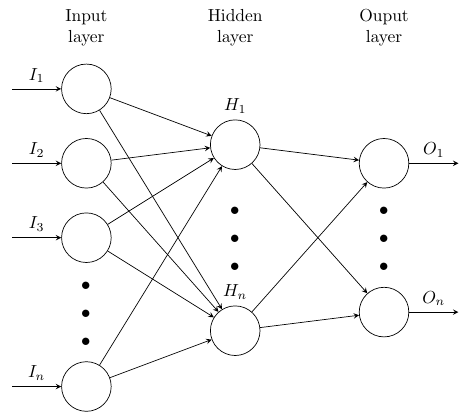
Figure 1. Schematic representation for an ANN structure. Each circle represents a neuron, where the I j means the neurons in the input layer, and the O j are the neurons in the output layer. All H j circles are the neurons in the hidden layers. The arrows represent the weighted